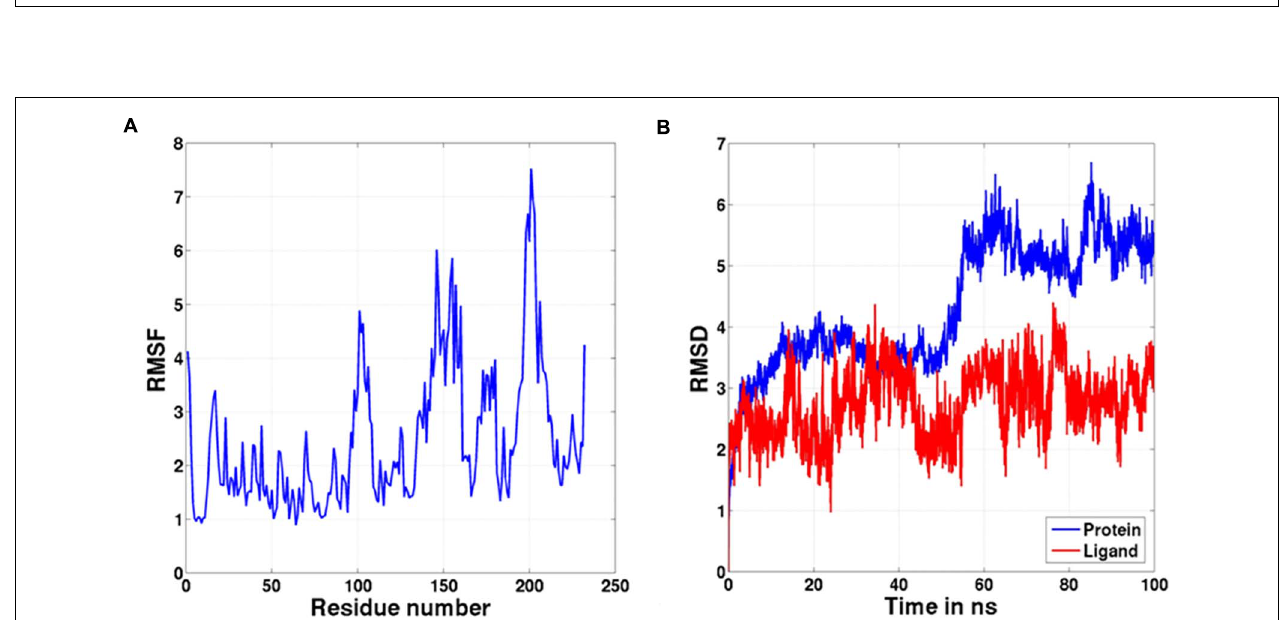
FIGURE 7 | The graph representing (A) RMSF and (B) RMSD values of the complex during the 100-ns molecular dynamic simulation.